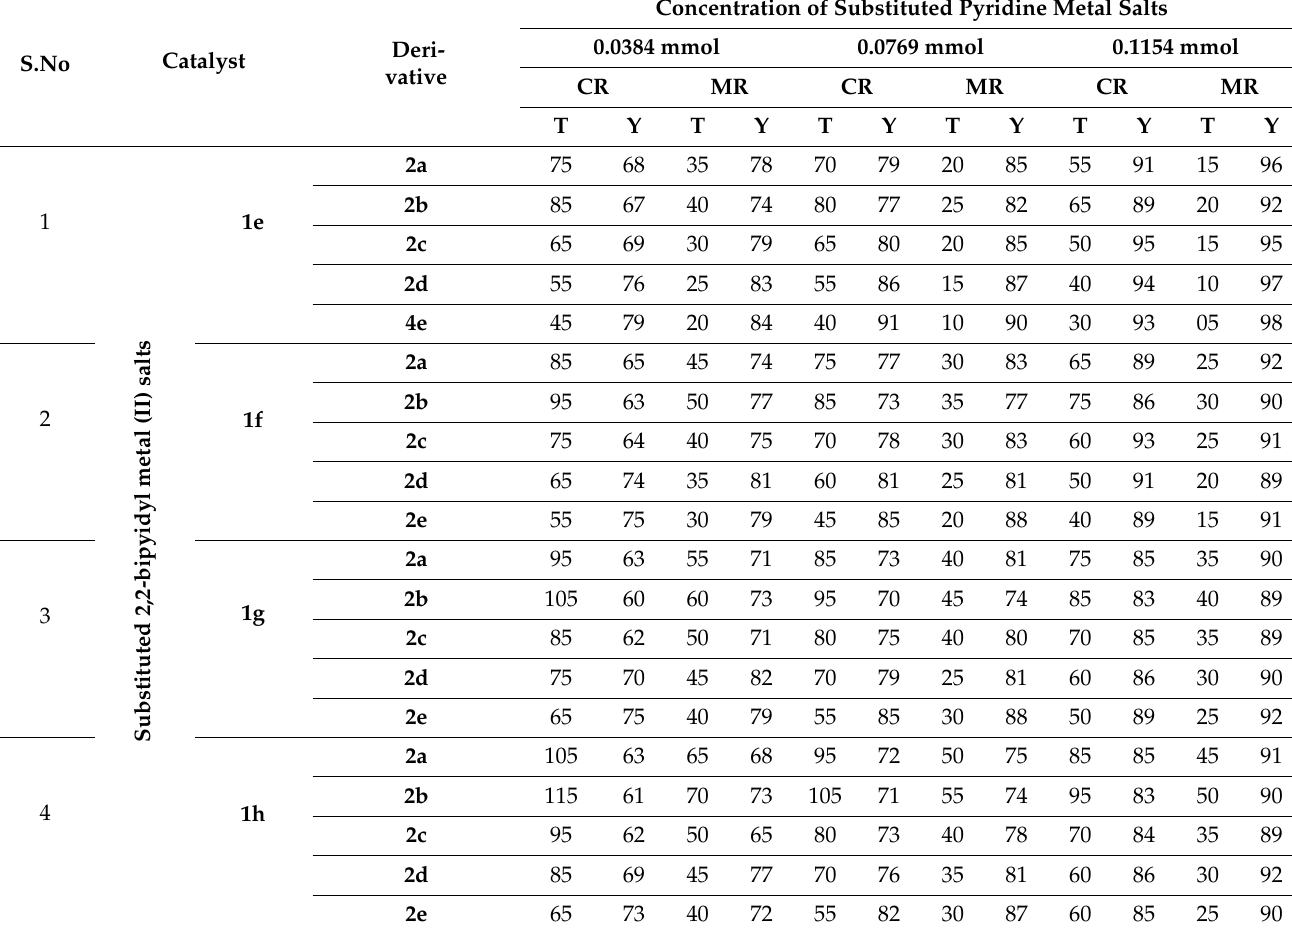
Table 5. Synthesis of β -Amino carbonyl derivatives assisted by various concentrations of complex 1 ( e – h ).